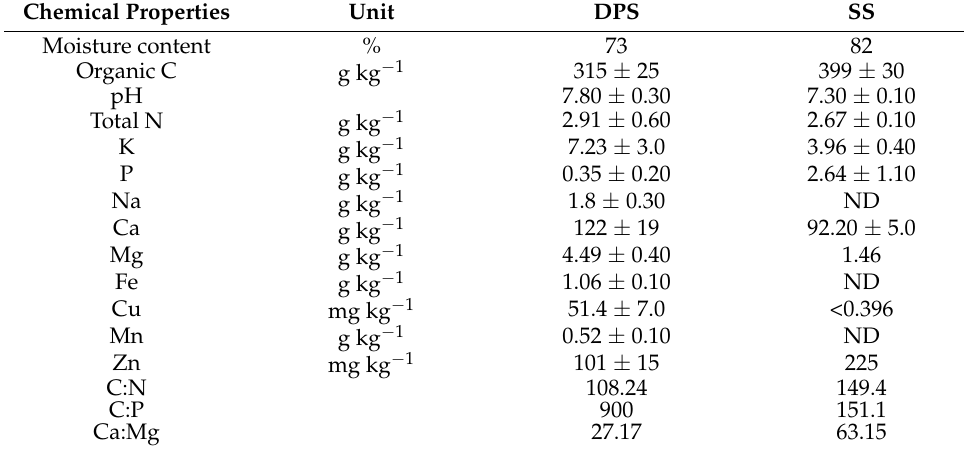
Table 2. Characteristics of the two biosolid amendments used in the experiment. Chemical